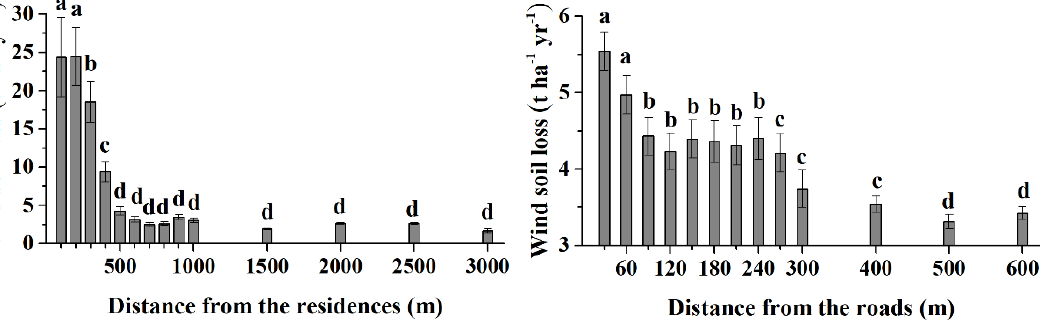
Figure 2. Wind soil loss of Kastanozem at separate buffer distances from residences and roads. Lowercase letters indicate the differences in wind soil loss for different buffer distances ( P <0.01).